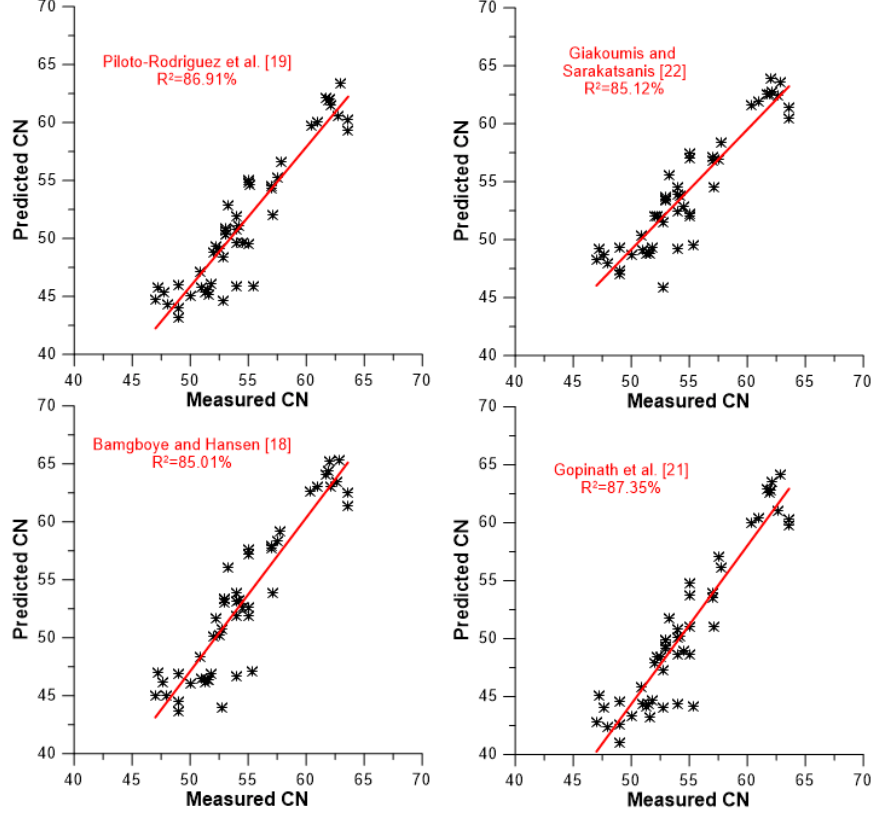
Figure 7. Comparison of predicted (equations from Section 3.1) vs. experimental CN values for the four compositional models (experimental data from the third column of Table 5).